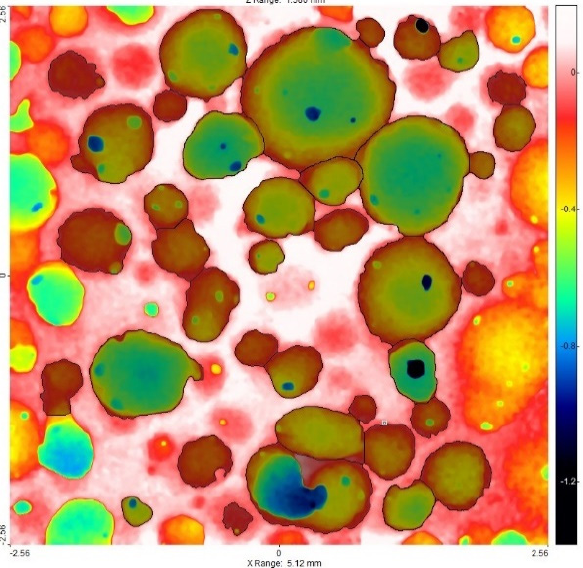
Figure 7. Example of an image resulting from the analysis with SPIP software.